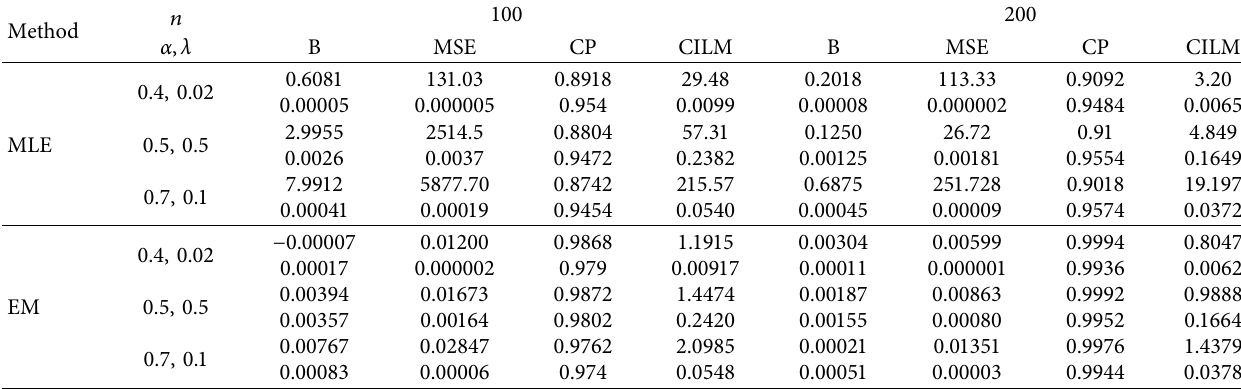
Table 1: Simulation results for MLE and EM estimators of the QL distribution for uncensored data (in every cell, the first and second lines are related to α and λ , respectively).